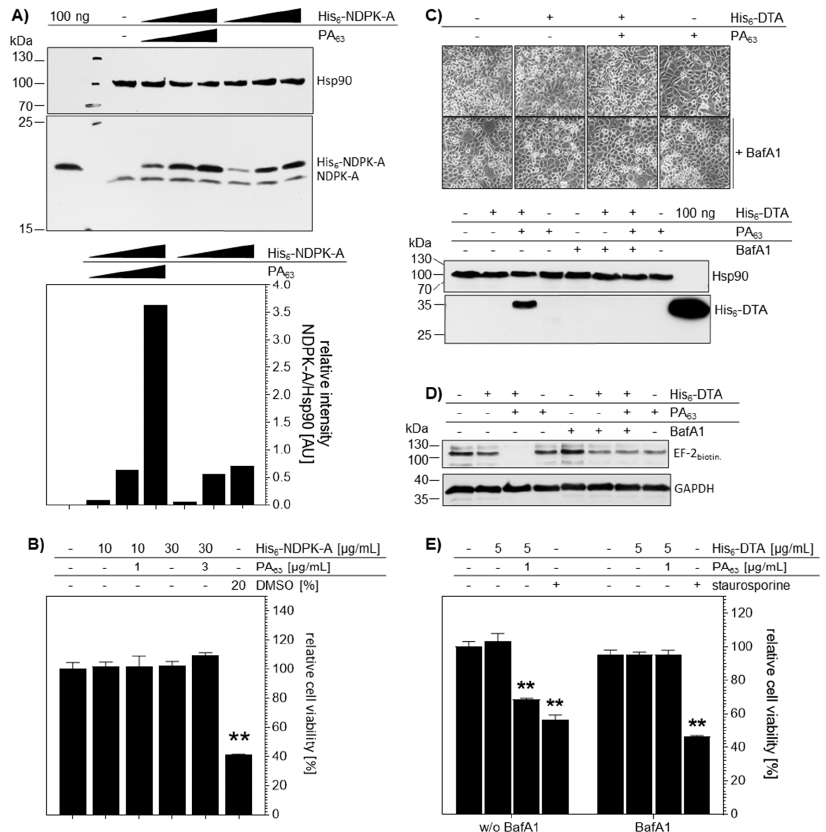
Figure 5. PA 63 mediates delivery of His 6 -NDPK-A and His 6 -DTA into MDA-MB-231 cells. ( A ) PA 63 delivers His 6 -NDPK-A into MDA-MB-231 cells in a concentration-dependent manner. After incubation of the cells with His 6 -NDPK-A and PA 63 (10 + 1, 18 + 6 or 30 + 3 µ g / mL) or His 6 -NDPK-A only (10, 18 or 30 µ g / mL) for 48 h at 37 ◦ C Western blot analysis was performed. The uptake of His 6 -NDPK-A (18 kDa) was detected with the specific anti-nm23-H1 antibody. The lane on the far left contains purified recombinant His 6 -taged NDPK-A only which was detected at 18 kDa. Endogenous NDPK-A is detected in the cell lysates at 17 kDa. Hsp90 was detected as loading control and densitometric analysis was performed using the ImageJ software. The signal intensity of His 6 -NDPK-A was quantified against Hsp90. ( B ) Cell viability is not a ff ected by the treatment of cells with His 6 -NDPK-A and PA 63 . After incubation of the cells with His 6 -NDPK-A and PA 63 or His 6 -NDPK-A-only for 48 h at 37 ◦ C, cell viability was determined by the MTS assay. Data were normalized to control (untreated cells). The known reduction by 20% (by vol.) DMSO was used as control. Data are given as mean ± SD, n = 3. ( C ) Uptake of His 6 -DTA is mediated by PA 63 and can be blocked by BafA1. Cells were incubated with BafA1 (30 nM) for 30 min at 37 ◦ C followed by 12 h incubation with His 6 -DTA (5 µ g / mL) with or without PA 63 (1 µ g / mL). Representative pictures depict no morphological changes after incubation and before sample preparation. His 6 -DTA was detected by an anti- His 6 -antibody. Detection of Hsp90 served as loading control. ( D ) PA 63 mediates cytosolic localization His 6 -DTA in MDA-MB-231 cells. After incubation with BafA1 (30 nM) for 30 min, His 6 -DTA (5 µ g / mL) with or without PA 63 (1 µ g / mL) was added for 12 h at 37 ◦ C. After cell lysis, In Vitro ADP-ribosylation was performed using biotinylated NAD + (10 mM) as substrate. Modified proteins were precipitated by strep-POD and biotinylated EF-2 was detected by immunoblotting. GAPDH expression was used as loading control. ( E ) Cell viability is decreased after treatment of cells with His 6 -DTA and PA 63 . Cell viability was determined via the MTS assay after 24 h of incubation at 37 ◦ C with His 6 -DTA with or without PA 63 . Staurosporine (1 µ M) was used as positive control. Data are normalized to untreated controls and given as mean ± SD, n = 3. Significance was tested using One-Way ANOVA followed by Dunnett’s multiple comparison test. ** p ≤ 0.01 vs. untreated